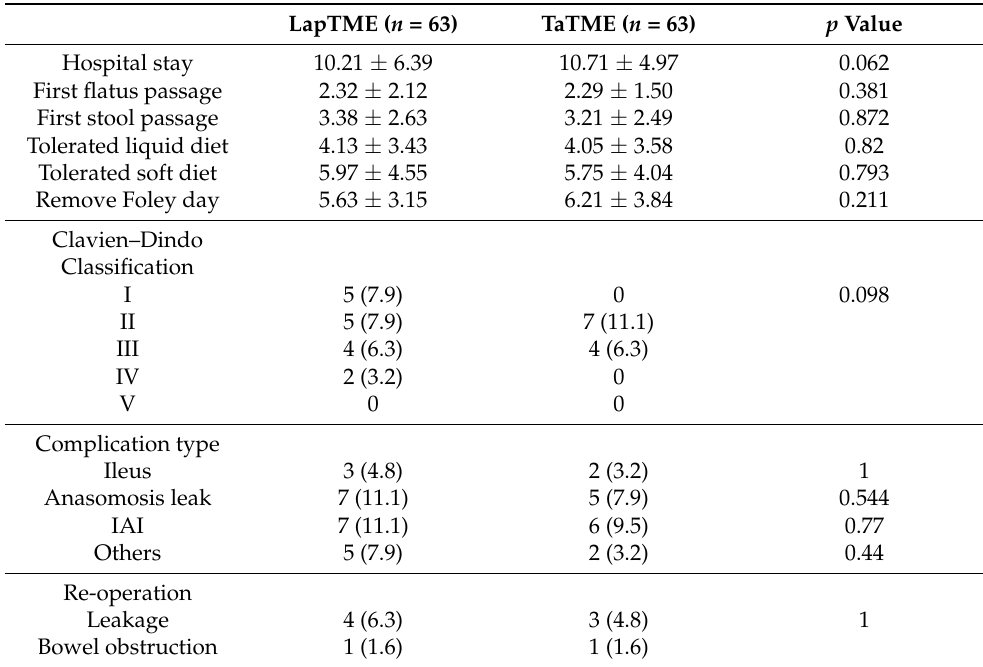
Table 3. Post-matching of short-term outcomes among patients with low rectal cancer underwent restorative